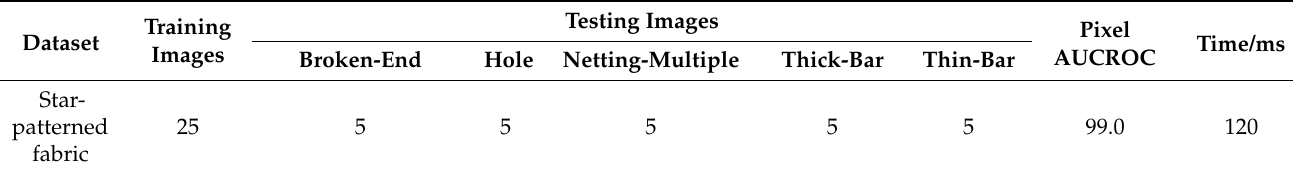
Table 6. Star-patterned fabric dataset and inspection results.